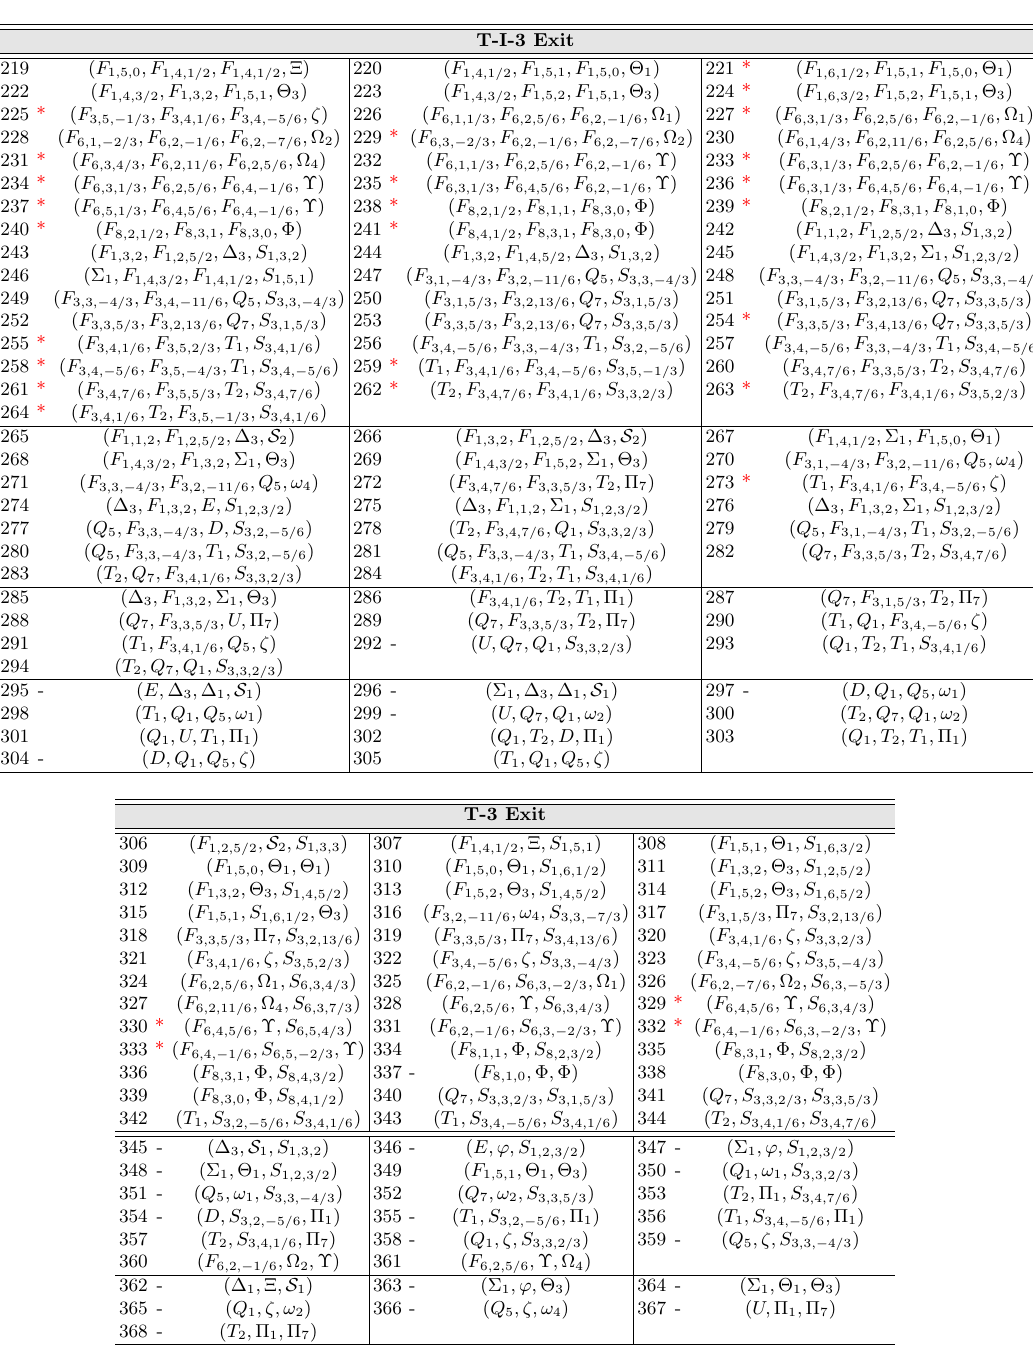
Table 3: TI-3 and T-3 models with scalar and fermionic exits. Table 7 . T-I-3 and T-3 models with scalar and fermionic